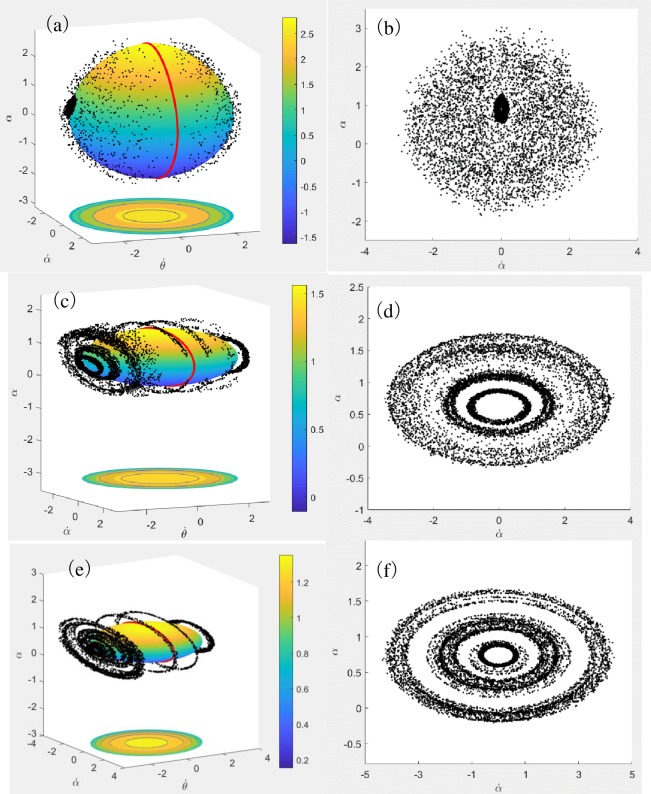
The dynamic simulations of the robot with different spring stiffnesses under the randomly uncertain disturbances.(a) and (b): the spring stiffness k = 1; (c) and (d): the spring stiffness k = 10; (e) and (f): the spring stiffness k = 20. Where (b), (d), and (f) are obtained by projecting the mapping points in (a), (c), and (e) onto the plane in the energy sphere.